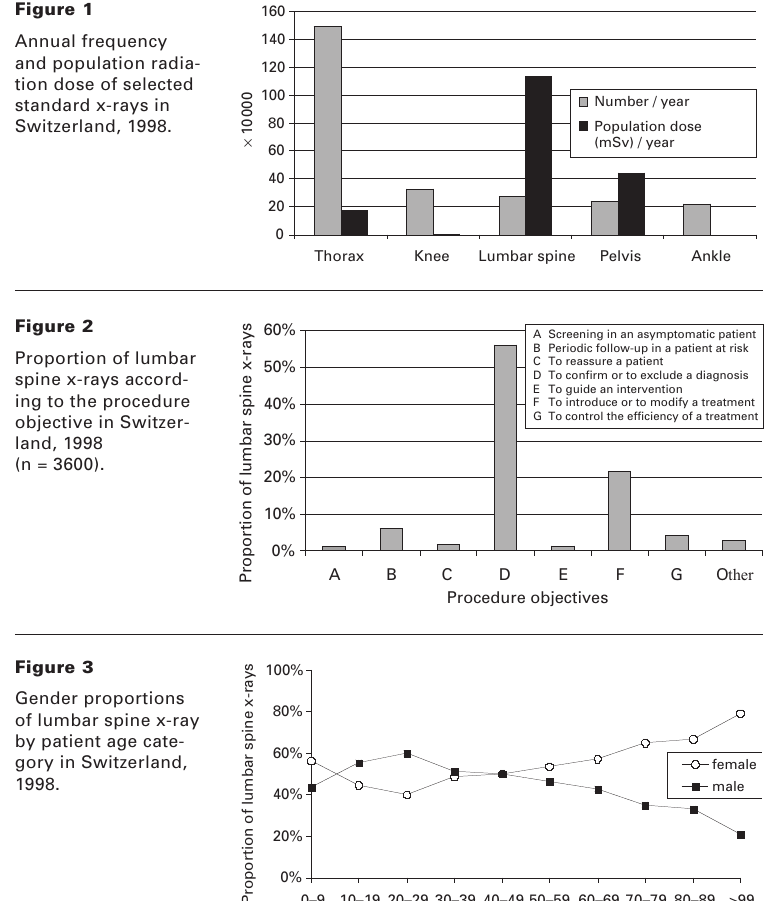
Gender proportions of lumbar spine x-ray by patient age cate- gory in Switzerland,